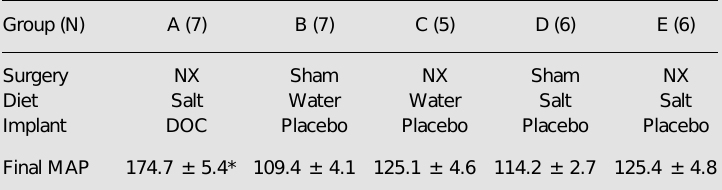
Table 1. Summary of the DOC-salt (group A) and normotensive control groups (B-E)